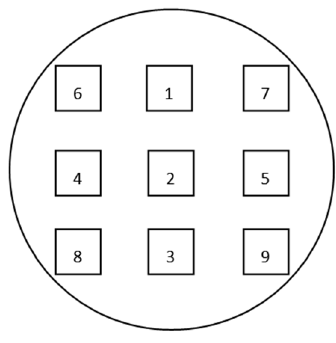
Figure 4. Schematic diagram of the location of the film thickness test point.